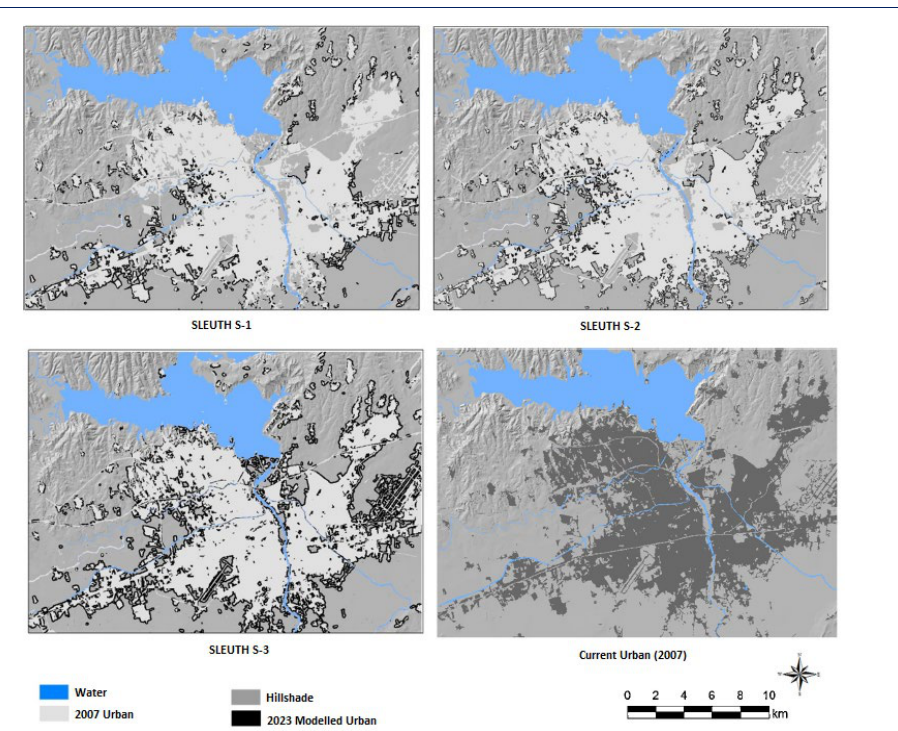
Figure 4 Comparison of potential urban growth for 2023 modelled with different scenario layers (Berberoglu 2011; Akın et al.,